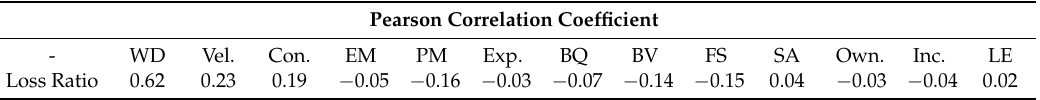
Table 2. Pearson correlation of the 13 final candidate predictors, see Table 1, and loss ratio. Significant correlations (5% significance level) are marked